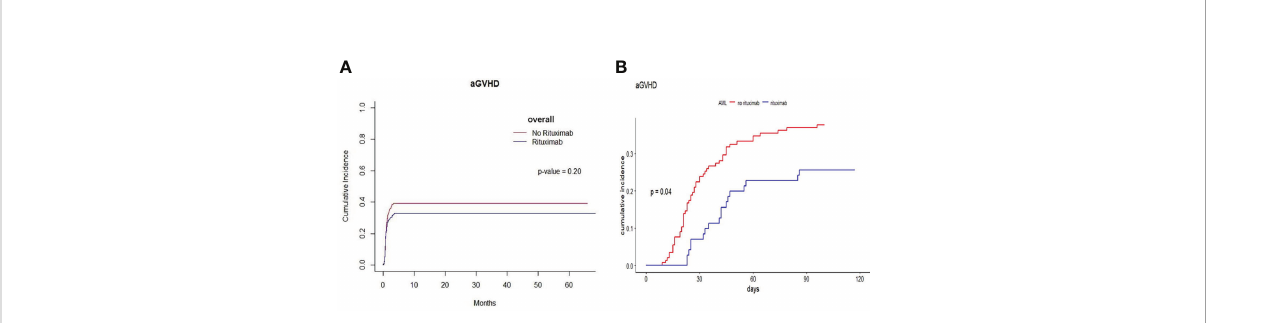
FIGURE 4 The cumulative incidence of aGVHD between rituximab and non-rituximab groups in different sets of populations. (A) The cumulative incidence of aGVHD in entire patient cohort. There was no difference in the cumulative incidence of aGVHD between rituximab and non-rituximab in entire patient cohort (P = 0.20). (B) The cumulative incidence of aGVHD in AML patients. There was comparable between 2 groups in the cumulative incidence of aGVHD in AML patients (P = 0.04).